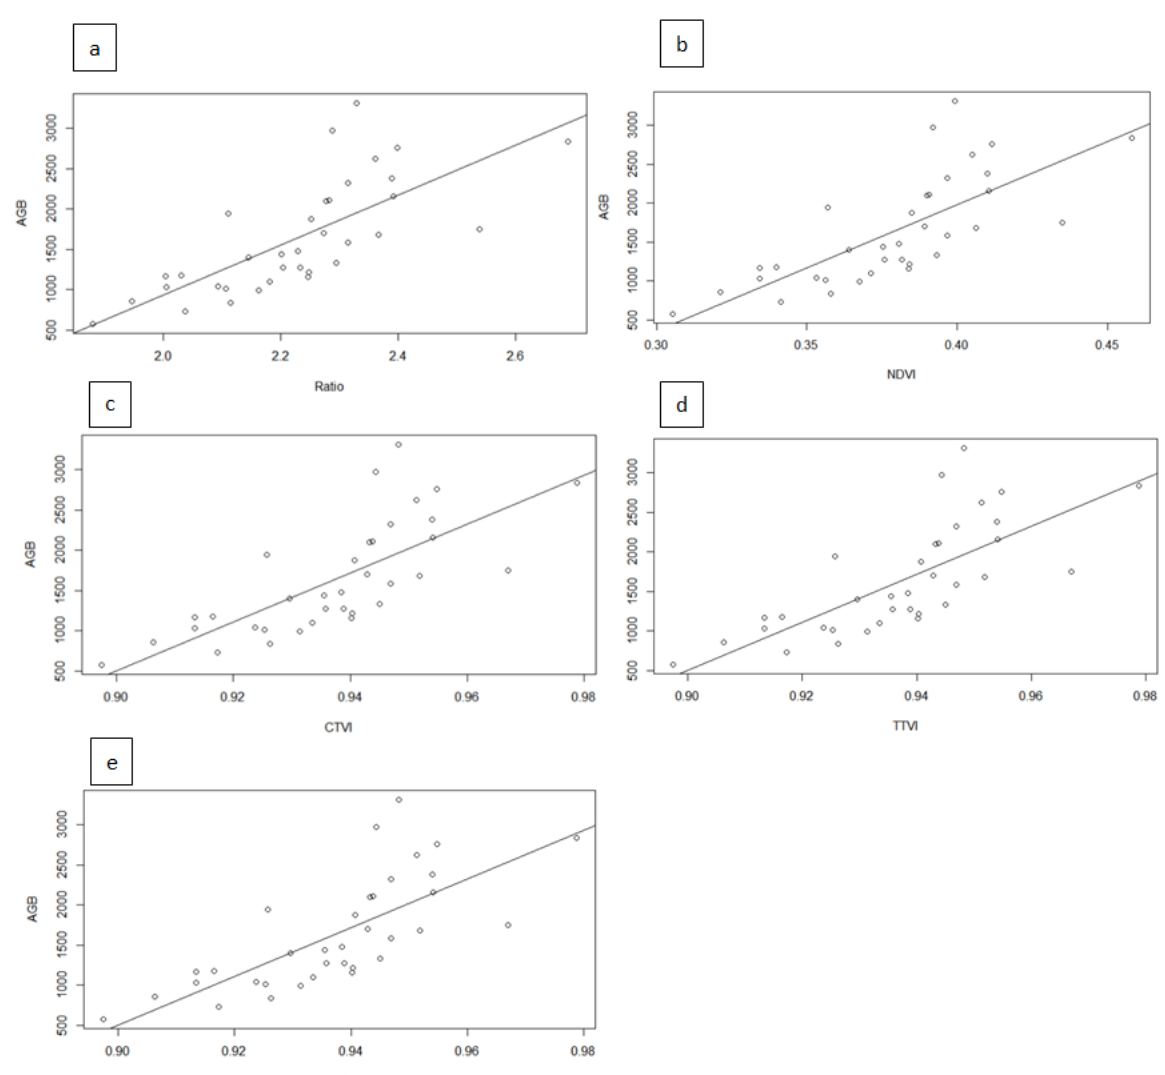
Figure 3. Regression analysis between slope based VIs and AGB—(a) between Ratio and AGB, (b) between NDVI and AGB, (c) between CTVI and AGB, (d) between TTVI and AGB, (e) between TVI and